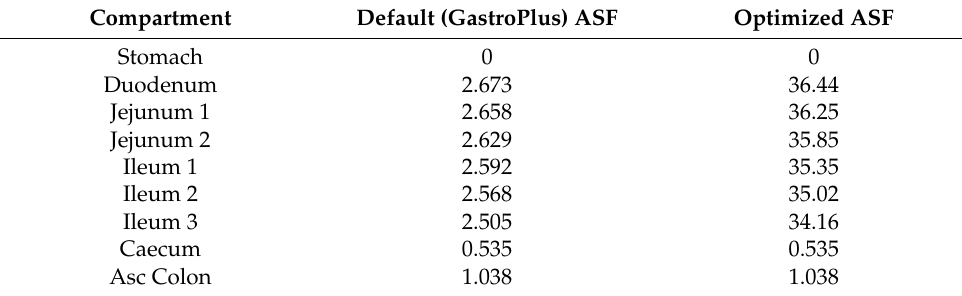
Table 4. ASF values before and after optimization of ACAT